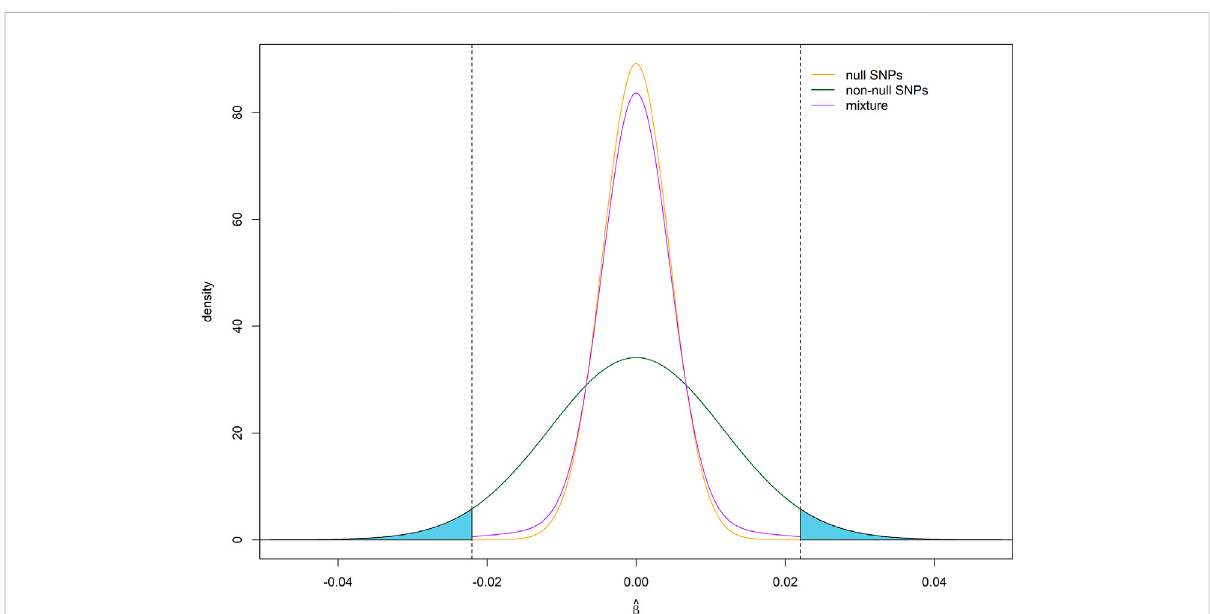
FIGURE 1 Assumed distribution of effect size estimates under a point-normal model. For illustration, the critical values for statistical signi fi cance are shown as vertical dotted lines, while average statistical power for detecting non-null SNPs is given by the shaded areas under density curve for non- null SNPs. Parameter values h 2 = 0.7, m = 60,000, π 0 = 0.9, n = 50,000, α = 5 × 10 − 8